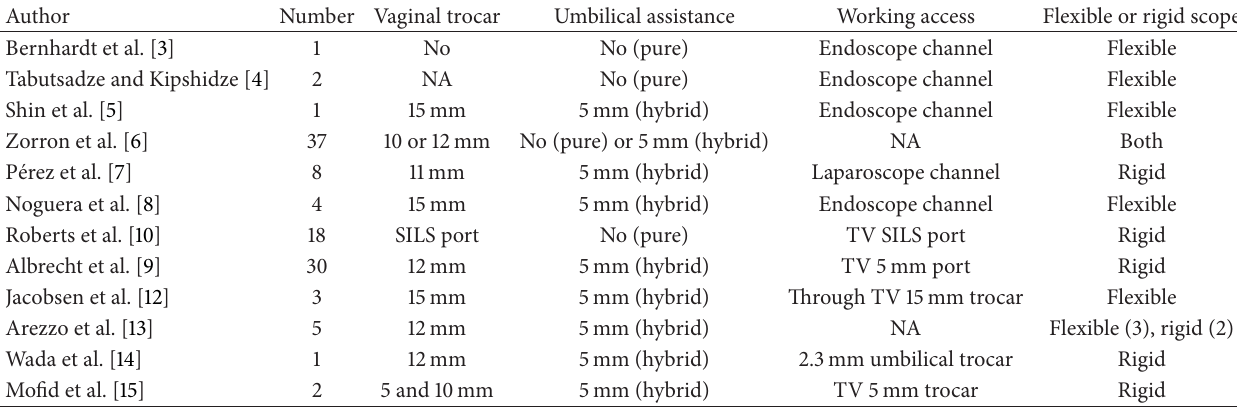
Table 4: Technical details of transvaginal